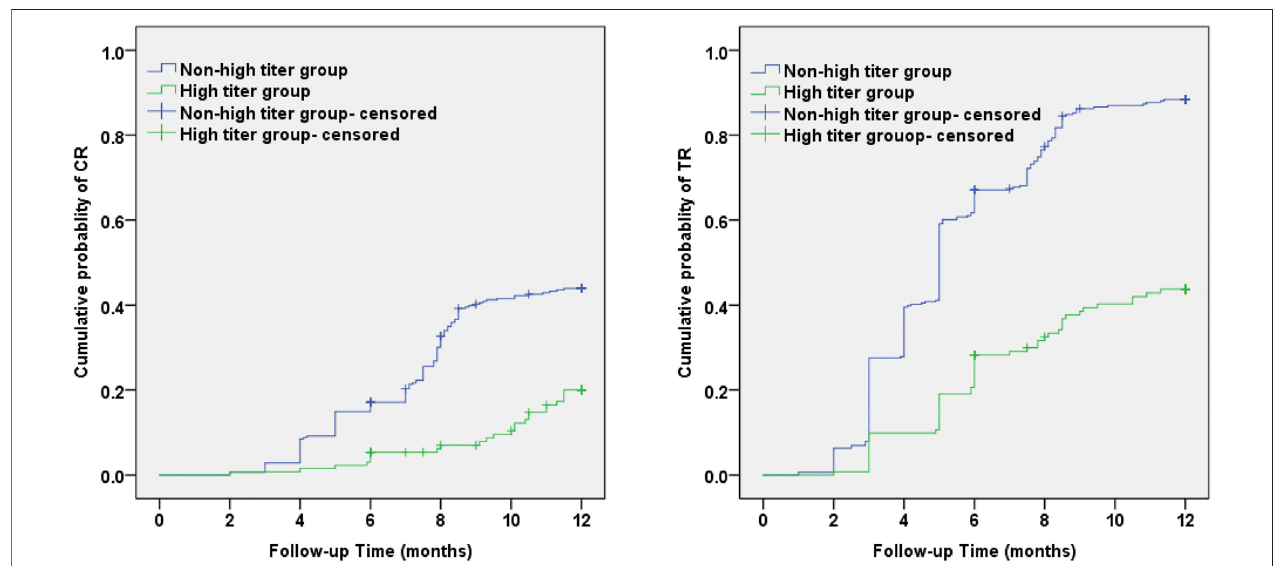
FIGURE 4 | Kaplan – Meier survival analyses of antibody against M-type phospholipase-A2-receptor level and cumulative probability of CR and TR during the 12monthsobservationperiod.IncidenceofCRandTRovertimewassigni fi cantlyhigherinthenon-hightitergroupthaninthehightitergroup(Log-Rank, p < 0.001).CR: complete remission; TR: total remission.